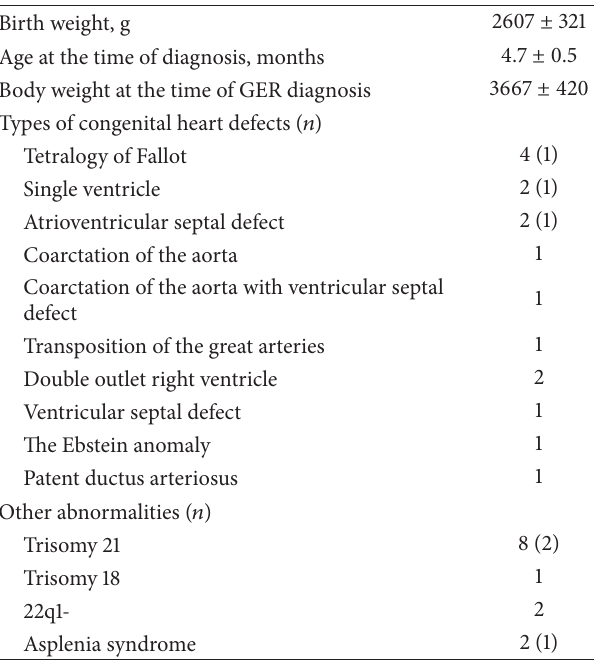
Table 1: Patients’ Characteristics.